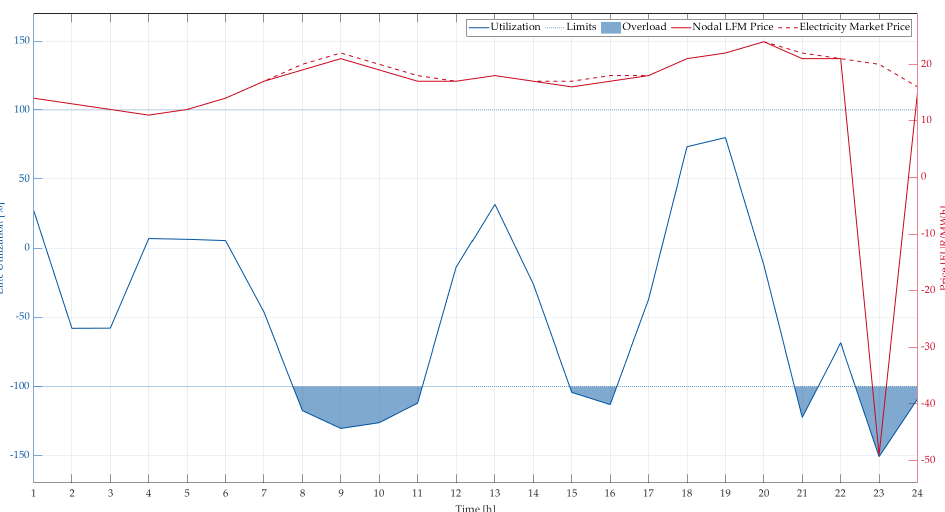
Figure 13. Utilization of line between nodes 2 and 3 and electricity price as well as nodal congestion prices in zone